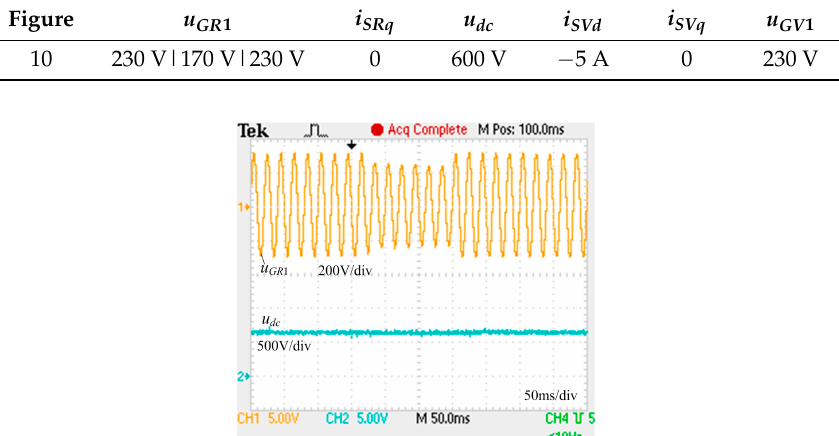
Figure 10. DC-bus voltage control experimental result, CH1: u GR 1 , 200 V/div; CH2: u dc , 500 V/div; 50 ms/div.